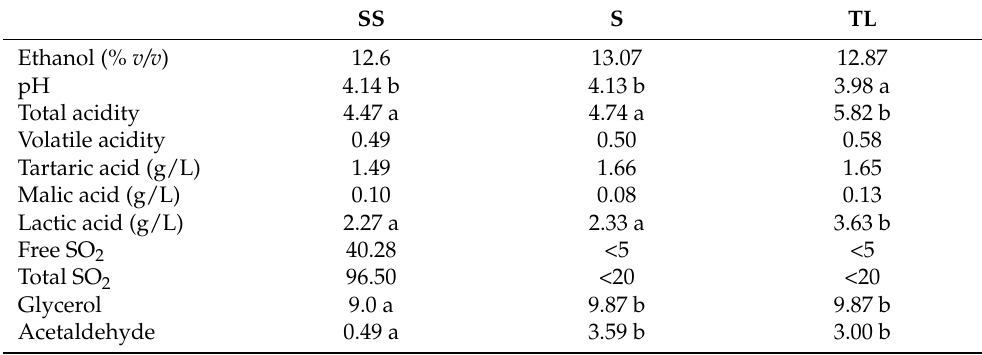
Table 1. Values of the physical–chemical parameters analyzed in the wines (SS: spontaneous sulfite, S: spontaneous without SO 2 , TL: inoculation with T. delbrueckii / L. thermotolerans at vatting without SO 2 ). SS S